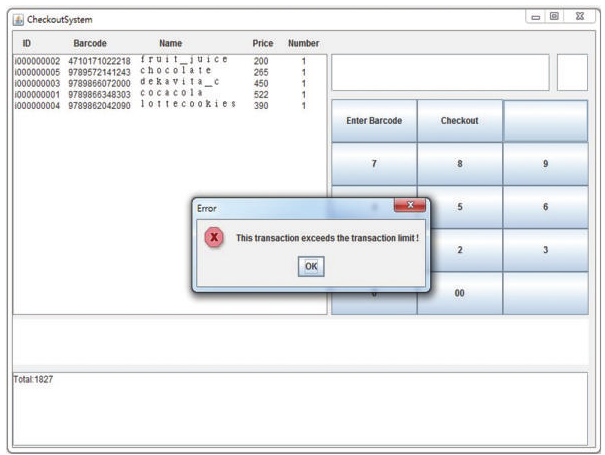
Figure 8: An example of a transaction exceeding the preset limit. different numbers of requests at the same time within